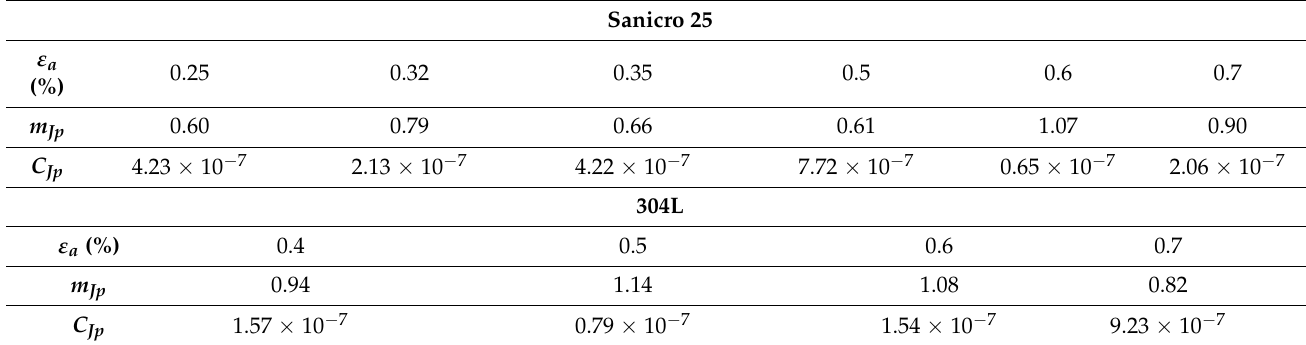
Table 4. Parameters for Hutaˇr model for every tested strain amplitude.